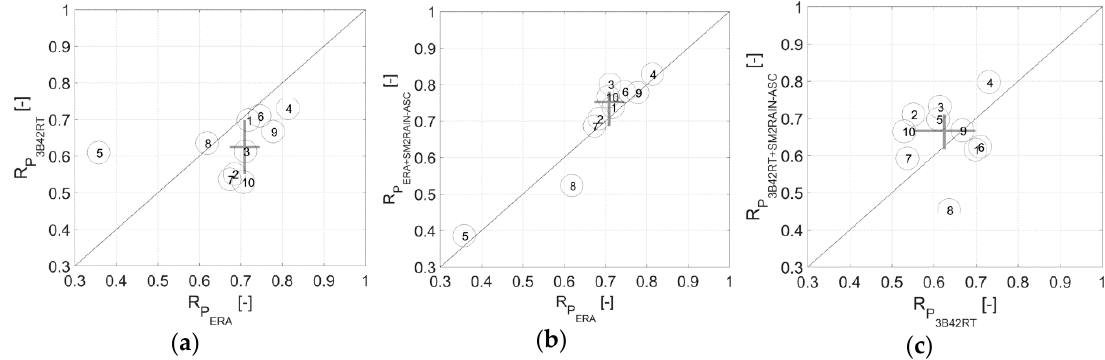
Figure 5. ( a ) comparison of correlations R between P ERA and P 3B42RT obtained with P EOBS for all study catchments during the validation period; ( b ) same as panel ( a ) but between P ERA and P ERA+SM2RAIN-ASC ; ( c ) same as panel ( a ) but between P 3B42RT and P 3B42RT+SM2RAIN-ASC . The points where the lines cross refer to the medians while the line edges represent the 25th and the 75th percentiles.